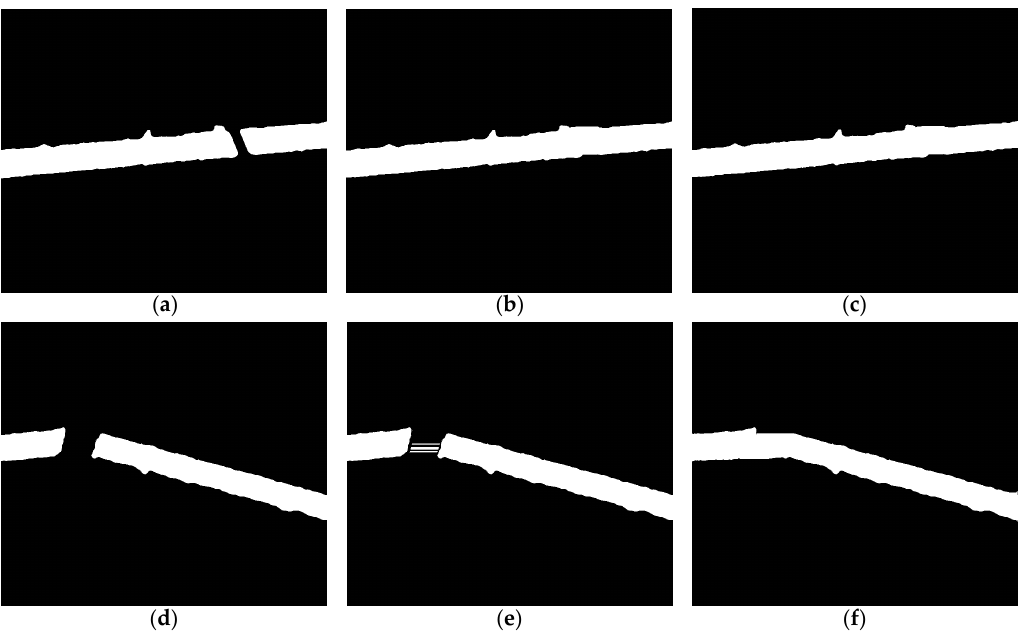
Figure 15. Example of multi-layer region growth. Left: ( a ) and ( d ) Riverway segments extraction results of B ’ 1,1 and B ’ 1,2 . Middle: ( b ) and ( e ) Region growth results of 3-layer search. Right: ( c ) and ( f ) Region growth results of 5-layer search.